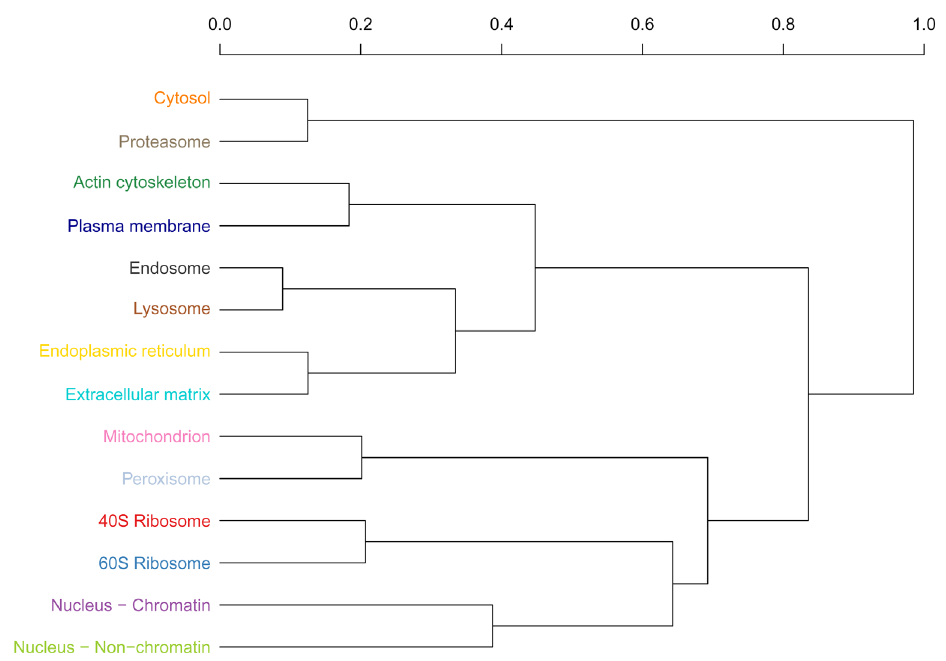
Figure 21. Hierarchical clustering of the average marker profiles summarising the relation between organelles